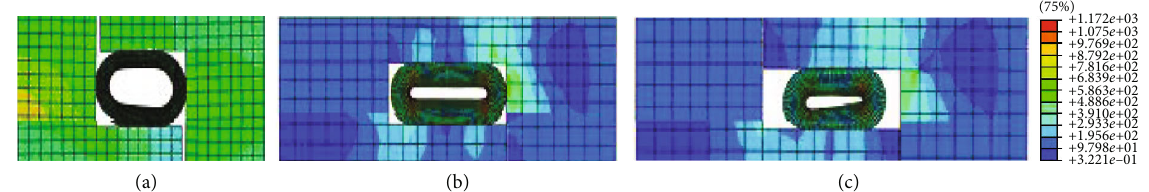
Figure 4: Compression equivalent stress for metal tubes of di ff erent outer diameters.